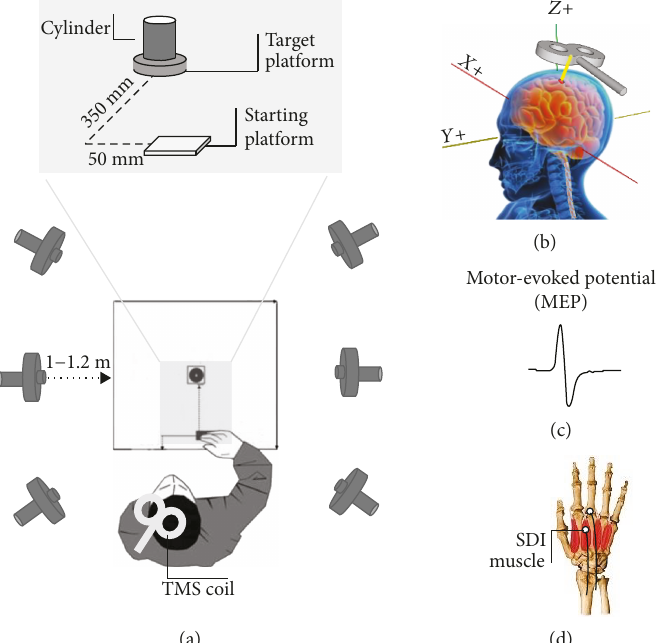
Figure 2: Experiment setup. A 3D optoelectronic SMART-D system was used to track the kinematics of the participant ’ s right hand by means of six video cameras (a). TMS coil placement over the participant ’ s left M1 hand area (b). Example of a TMS-evoked MEP (c). The targeted second dorsal interosseous (SDI) muscle